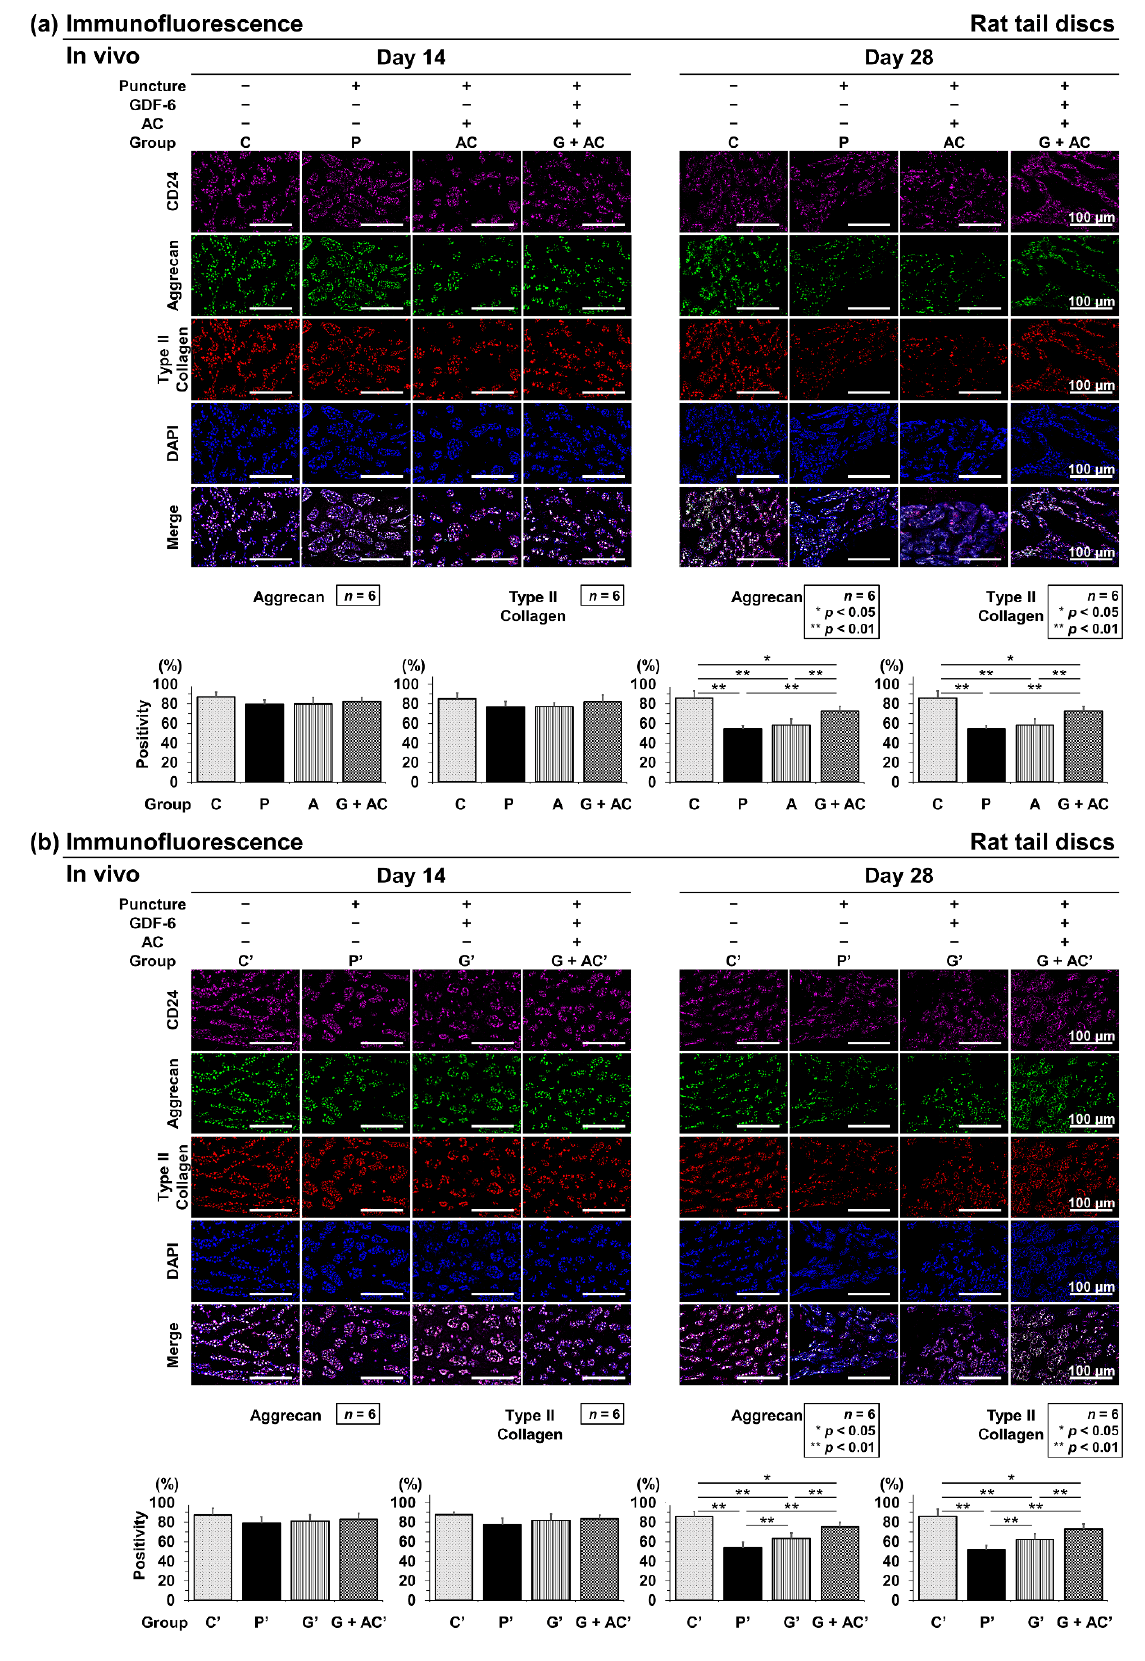
Figure 7. ( a ) Effects of co-administration of growth differentiation factor-6 (GDF-6) and atelocollagen (AC) on aggrecan and type II collagen expression compared with AC alone in a rat tail puncture